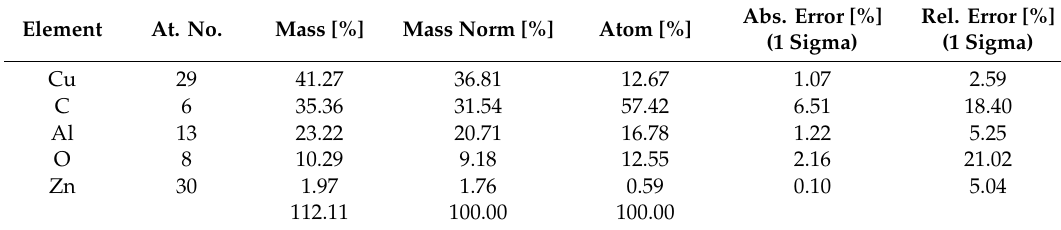
Table 5. EDX Test Results.